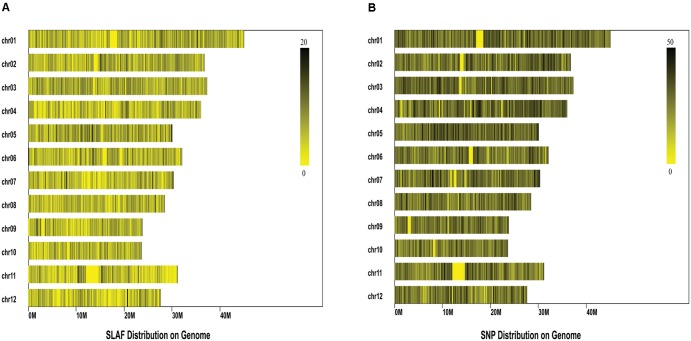
Distribution of the Specific-Locus Amplified Fragment (A) and SNPs (B) on the 12 rice chromosomes. Each row represents one chromosome and each vertical bar at the chromosome represents an interval of 100 K window. The ruler on the top right of each figure shows the density of SLAF/SNPs within each interval.